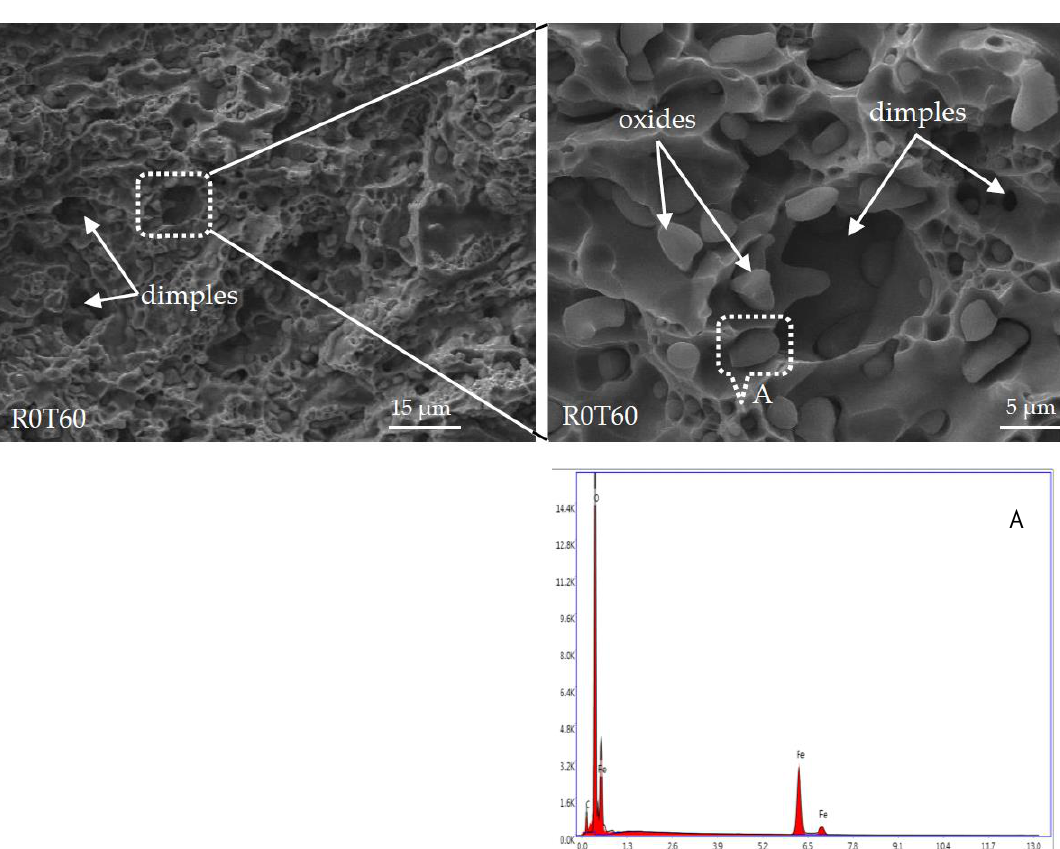
Figure 19. SEM images of the fractured surface from the 60 min sintered un-reinforced test specimen (100 vol.% Fe), and EDX spectrum of the region of A indicated by the white dashed line.